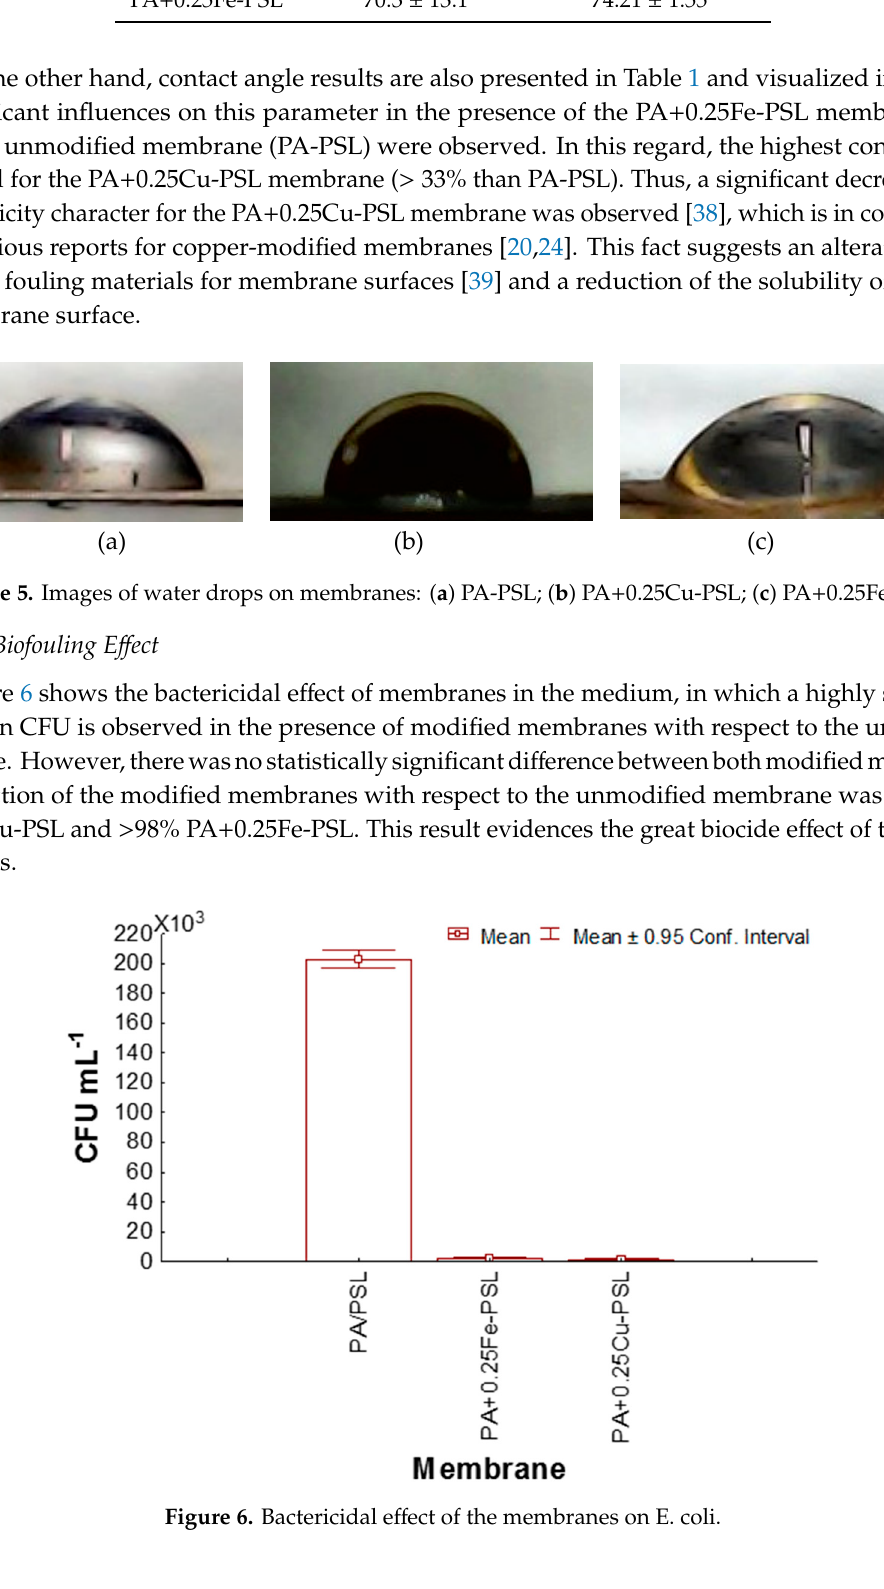
Table 1. Surface properties of the membranes.